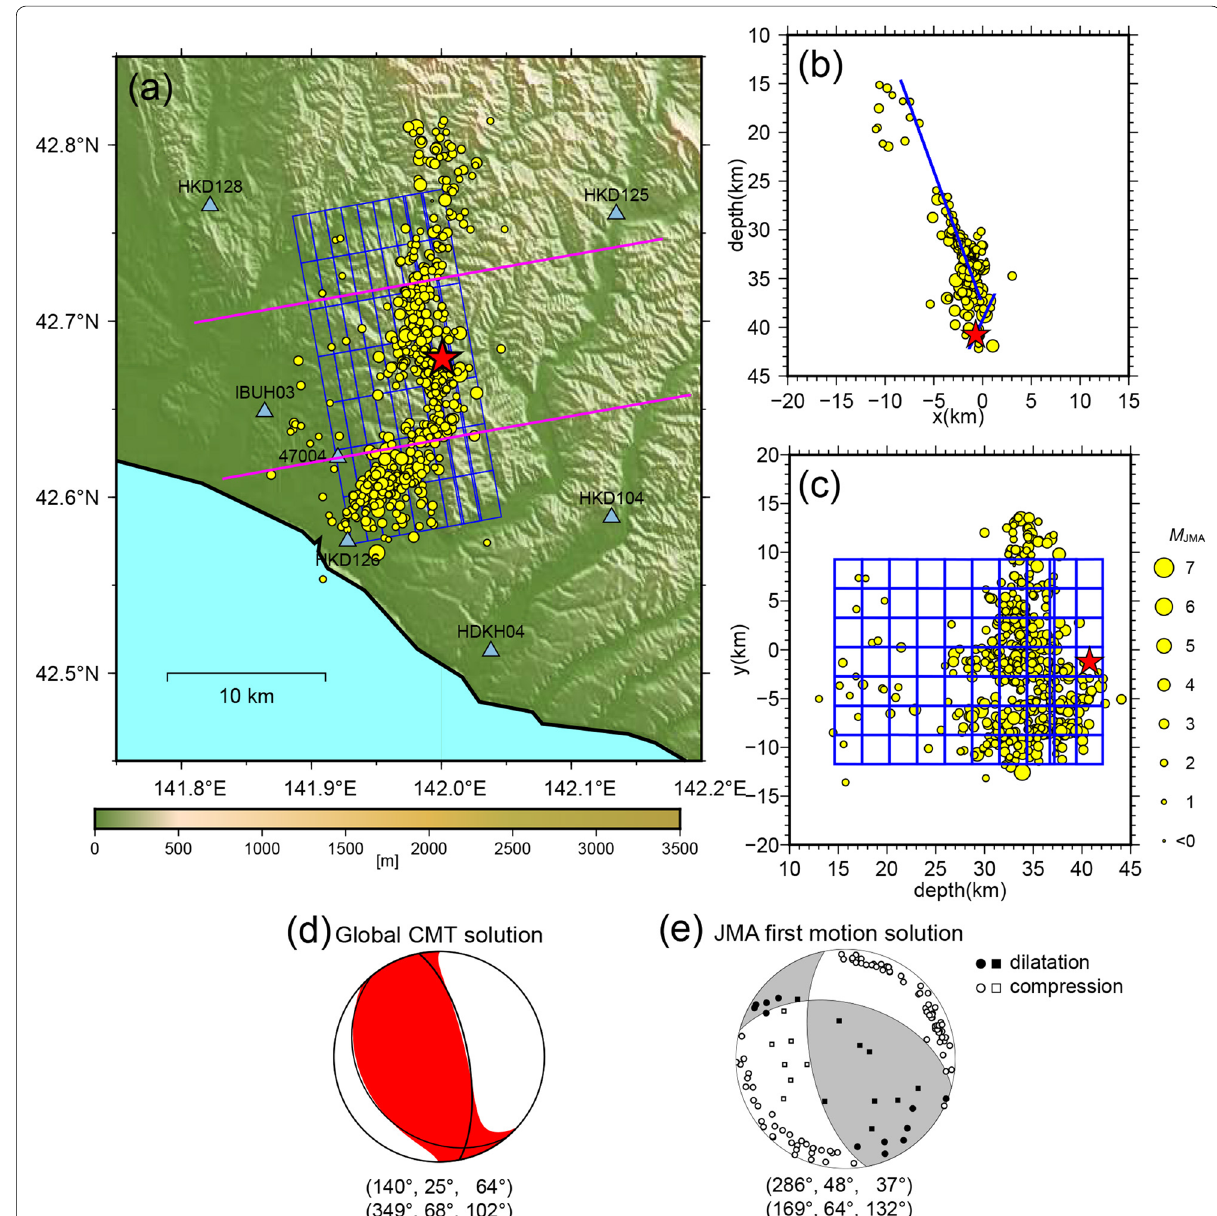
Fig. 2 Fault model, 24-hour aftershock distribution, cross sections, and focal mechanisms. a Relocated aftershock distribution. b Cross section of the region between the purple lines in a viewed from N170°E. c Cross section viewed from N80°E. The blue lines indicate the fault model with the two planes. The yellow circles indicate the epicenter/hypocenter of the aftershock and their size represent M JMA . The other aspects are the same as in Fig. 1. d Global CMT and e JMA first motion solutions. Strike, dip, and rake angles are shown below the focal mechanisms. The squares and circles indicate the stations whose epicentral distance are less than and more than 50 km, respectively. The black and white colors indicate dilatational and compressional first motions,